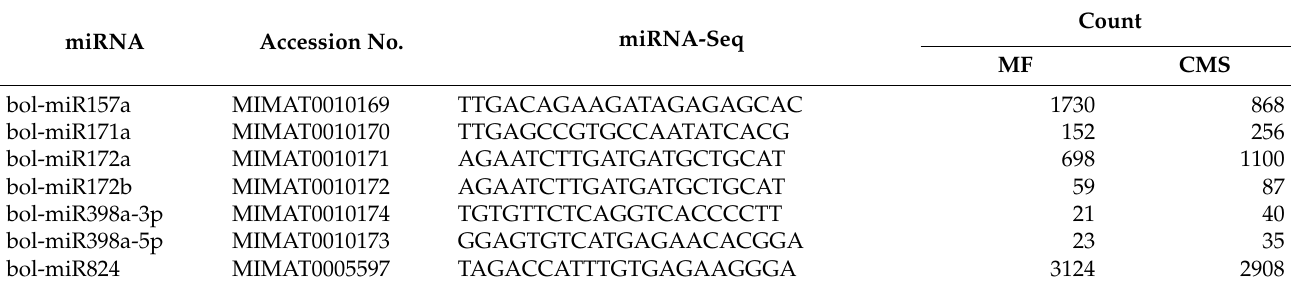
Table 2. Identification of known miRNAs in cabbage flower buds from they MF and CMS